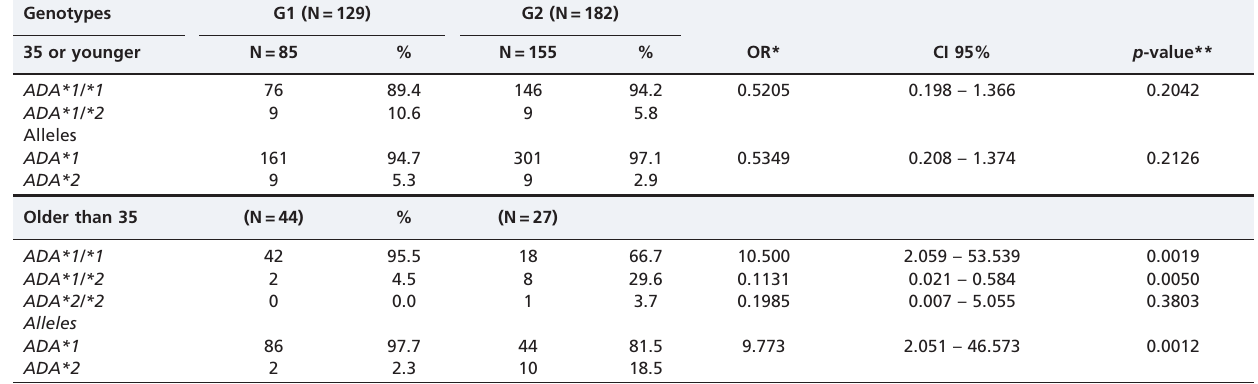
Table 2 - A comparison of the frequencies of ADA alleles and genotypes in women with (G1) and without (G2) RSA aged 35 years or younger and those older than 35 years of age.